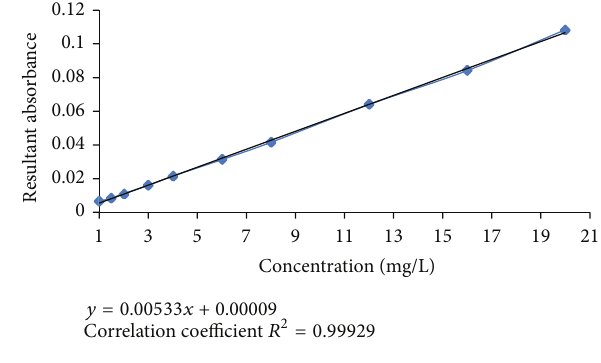
Figure 2: Standard